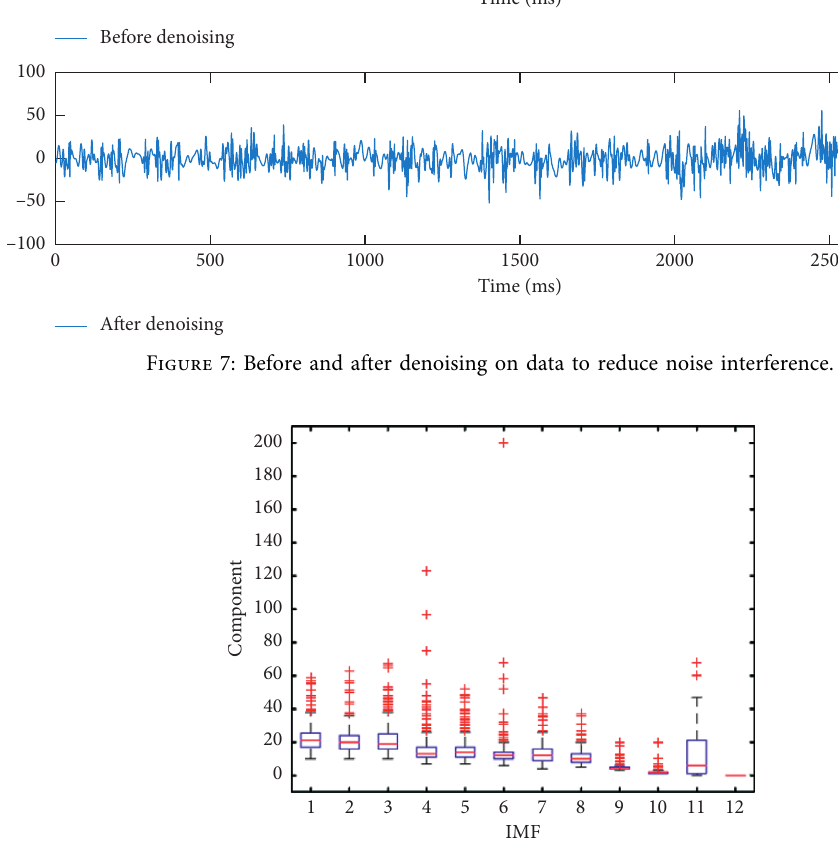
Figure 8: Box-plots of sample data processed by improved CEEMDAN.